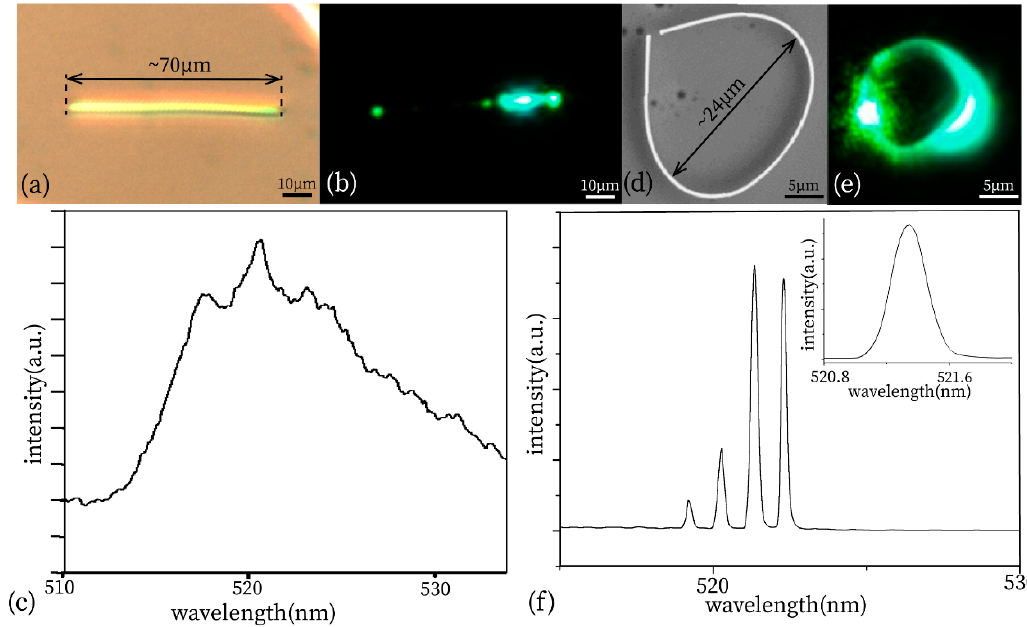
Figure 5. ( a ) Microscope photo under white-light illumination. ( b ) Microscope photo under UV excitation. ( c ) Spectral picture of single nanowire. ( d ) SEM picture of nanowires ring cavity under excitation. ( e ) Microscopic picture of the sensitive unit under excitation. ( f ) Spectral picture of the sensitive unit.